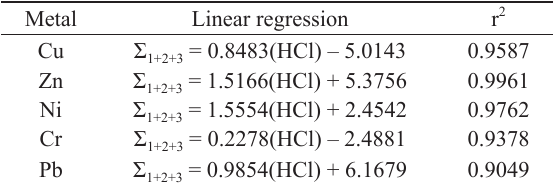
Best-fit regression models correlating concentrations of metals from sediments and extracted by 0.5 mol/L HCl, as well as the sum of the three labile phases extracted by sequential extraction procedure BCR (n = 10). Linear